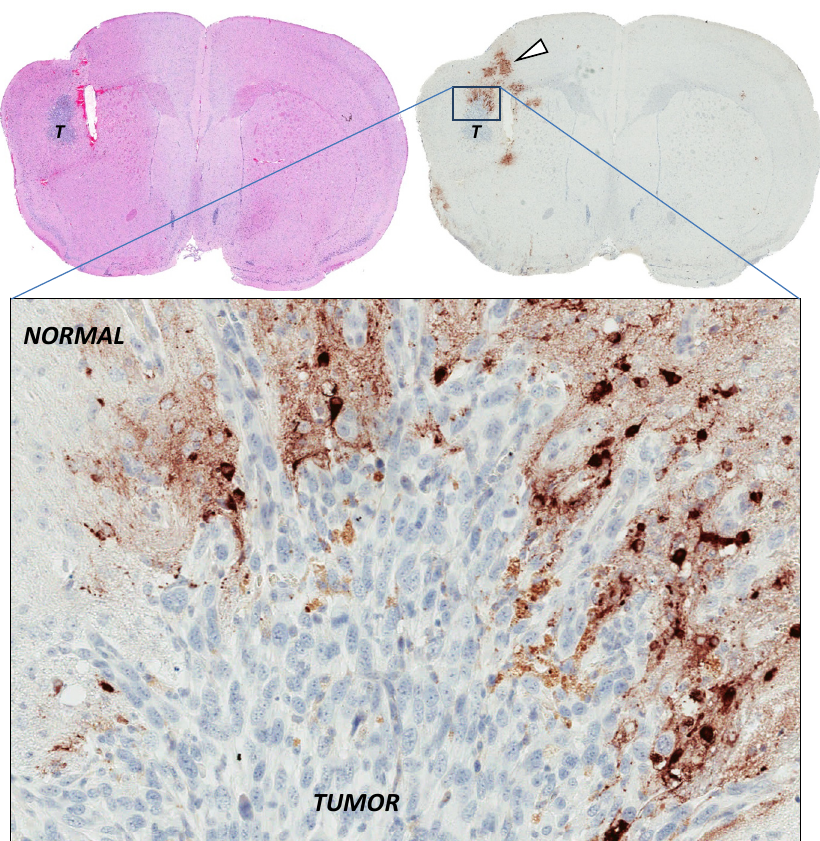
Figure 3. Restricted infection by oncolytic virus in the absence of physical barriers. Intracranial syngeneic Balb/c mouse DBT gliomas (T) were injected into the same stereotactic coordinates with high-dose oncolytic Semliki Forest virus (SFV) vector VA7. Brains were sampled and stained for SFV antigens 24 h post virus injection (in brown), showing that SFV predominantly infects normal brain parenchymal cells rather than glioma cells. DBT tumors are homogeneous and void of thick extracellular matrix deposits, as seen in Figure 1, arguing that tumor cells resist virus infection by other intracellular means